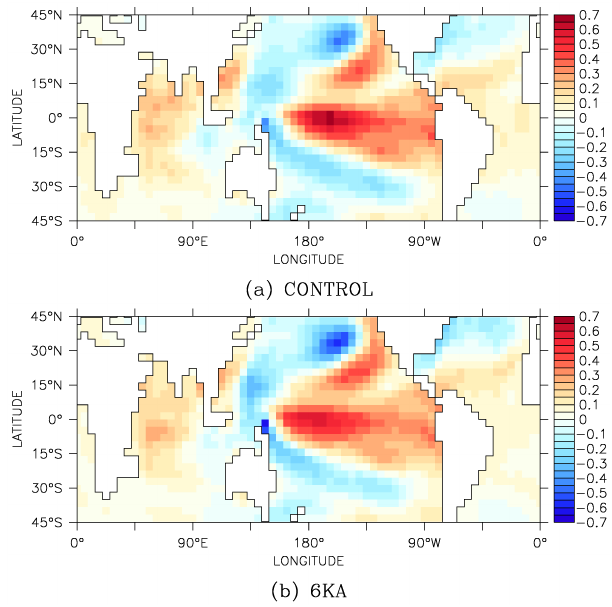
Fig. 4. The leading principal component (K) of the monthly sea surface temperature anomalies in the region 45 ◦ S–45 ◦ N for years 201–1200 of experiments CONTROL and 6KA: (a) CONTROL, and (b) 6KA.